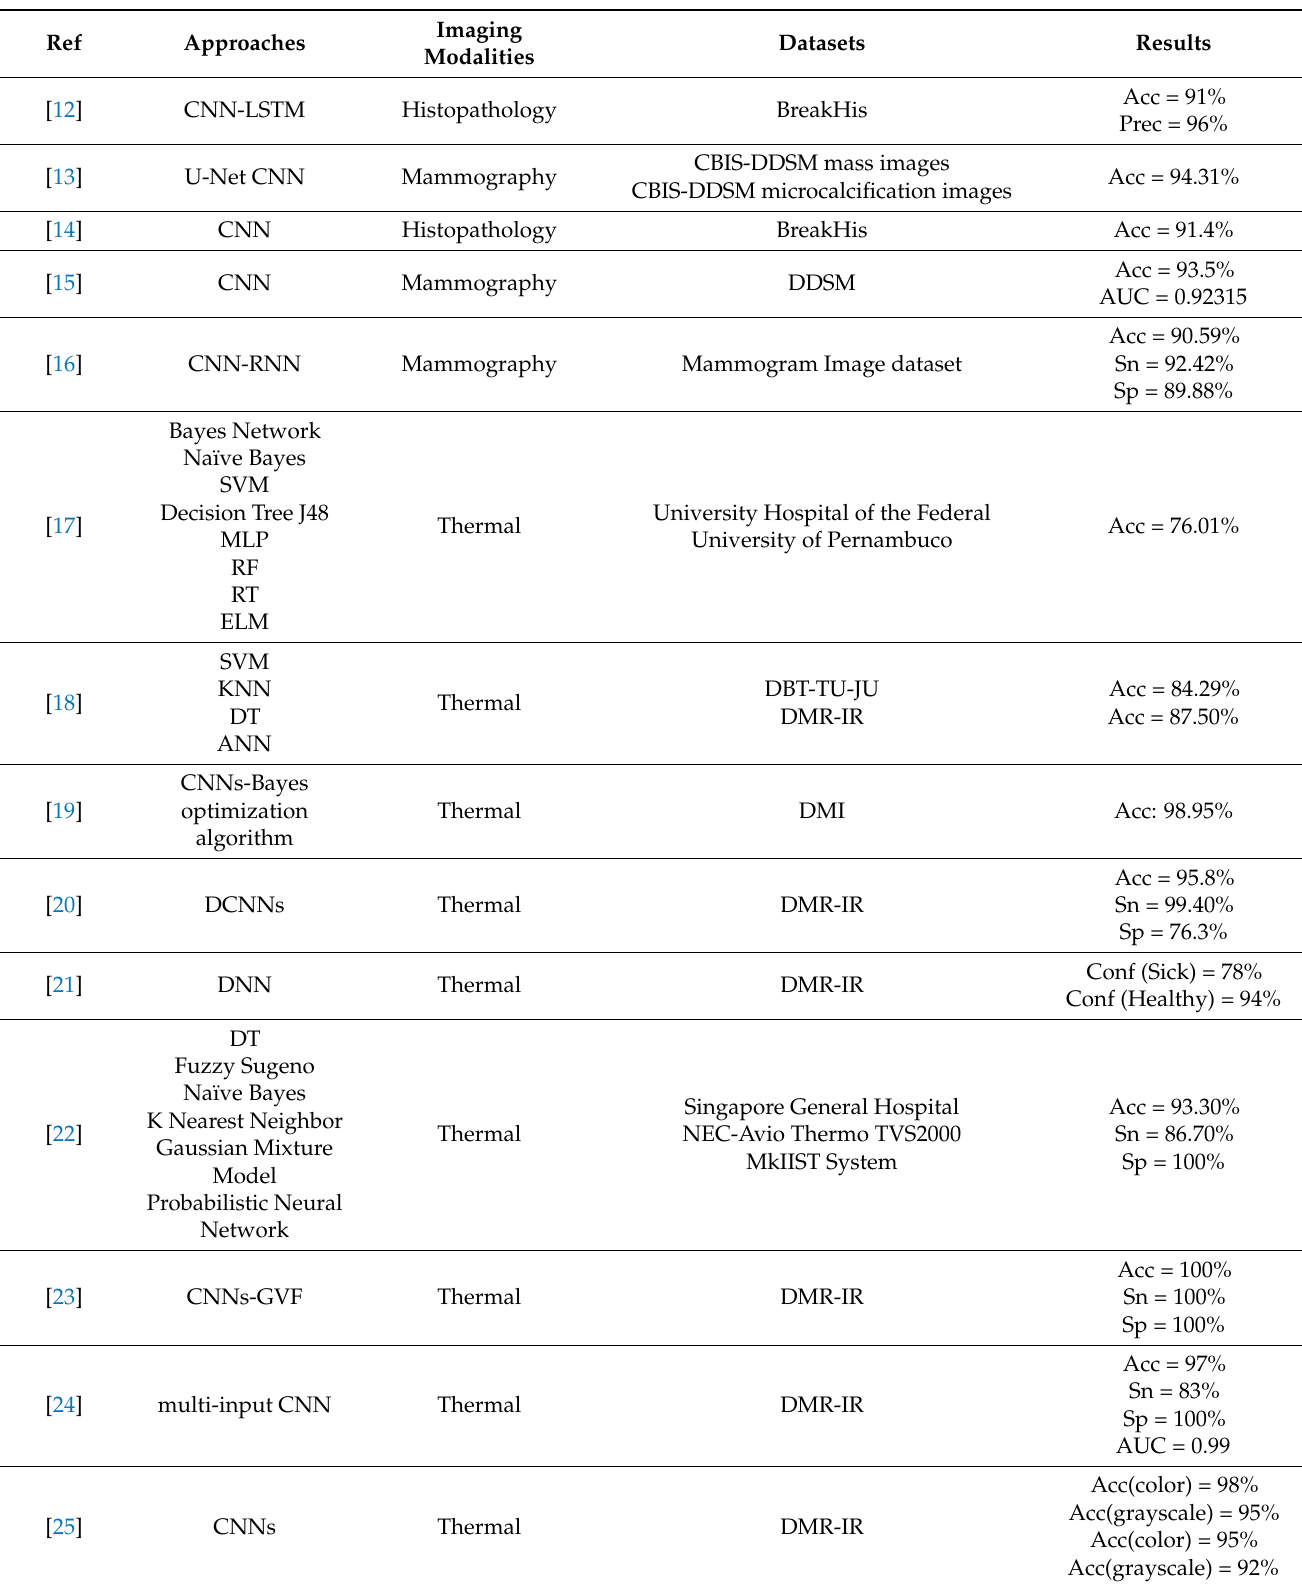
Table 1. Breast cancer detection and classification